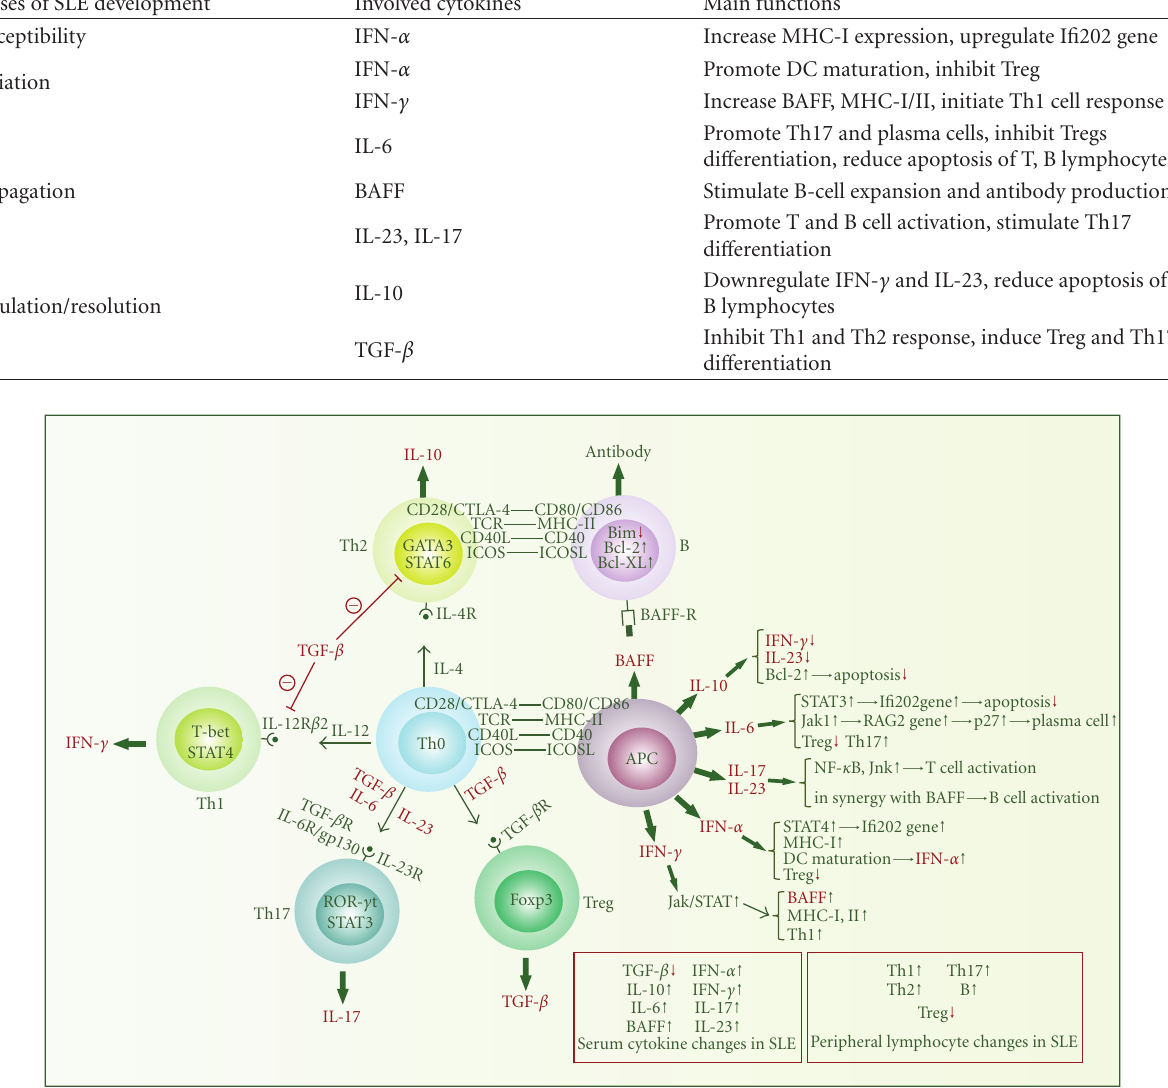
Figure 1: Cytokine network that links innate and adaptive immunity. This figure illustrates the functions of some key cytokines secreted by several most important types of immune cells. APC refers primarily to monocytes, macrophages, and dendritic cells. In SLE, TGF- β and IL-10 mainly exhibit anti-inflammatory e ff ects, while IL-6, BAFF, IFN- α , IFN- γ , IL-17, and IL-23 function as proinflammatory cytokines. These cytokines have cross-talks by a ff ecting one another, thereafter constituting a complex